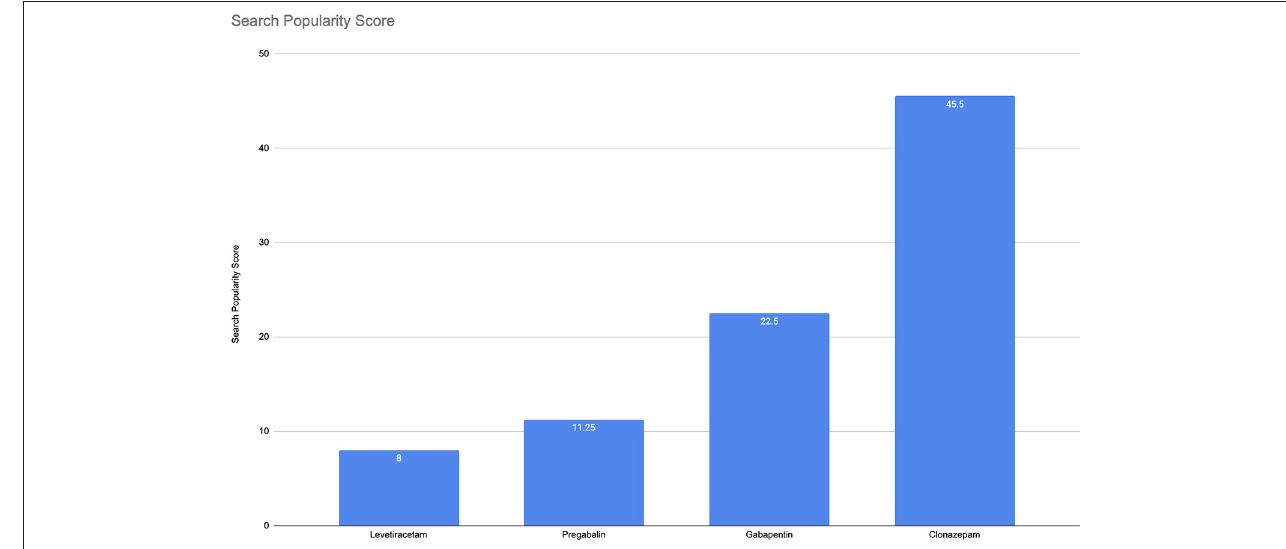
FIGURE 1 | Search Popularity Score (SPS) in the Google analytics domain for the four